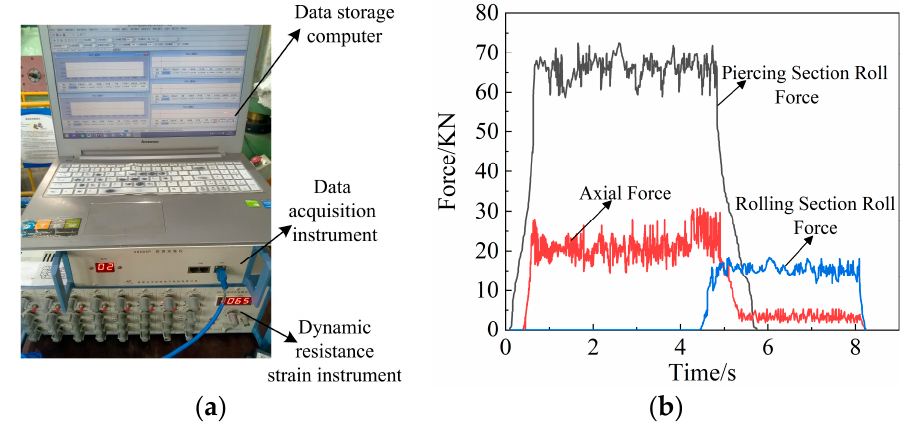
Figure 10. Rolling force detection: ( a ) rolling force acquisition system; ( b ) rolling force curve.